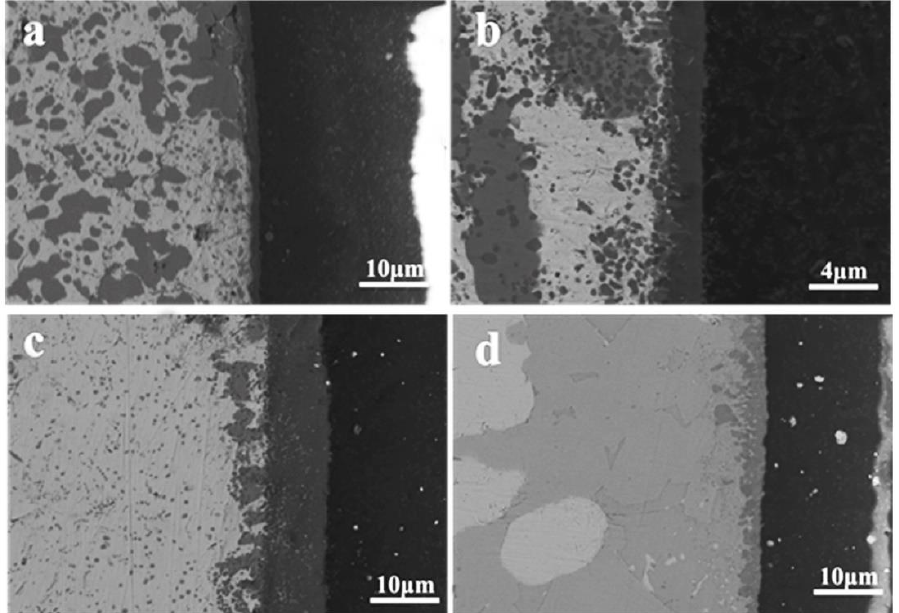
Figure 6. The backscattered images of joints brazed at different temperatures ( a ) 800 °C, ( b ) 820 °C,